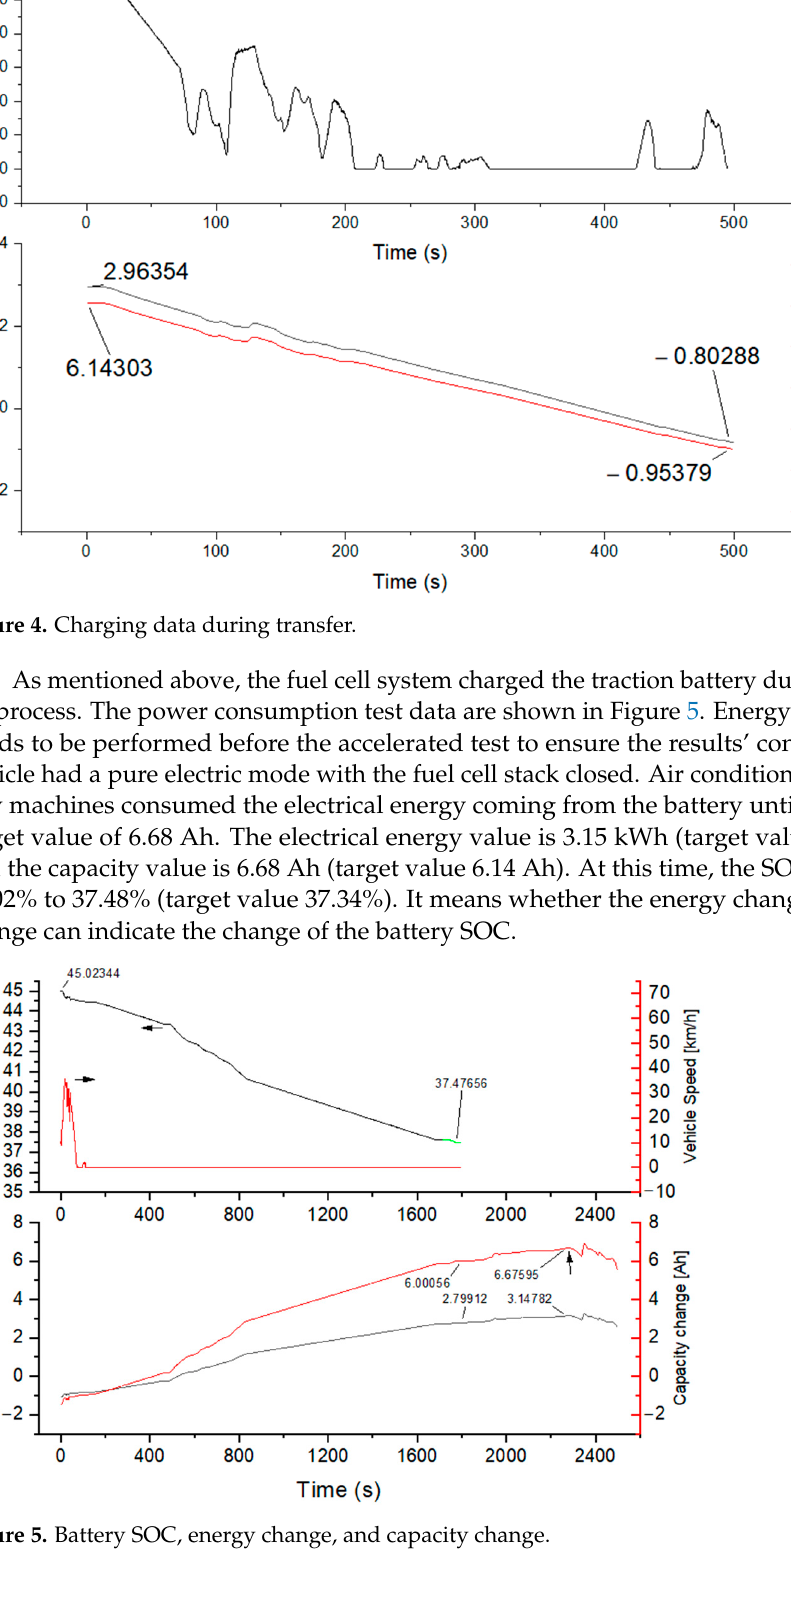
Figure 5. Battery SOC, energy change, and capacity change.